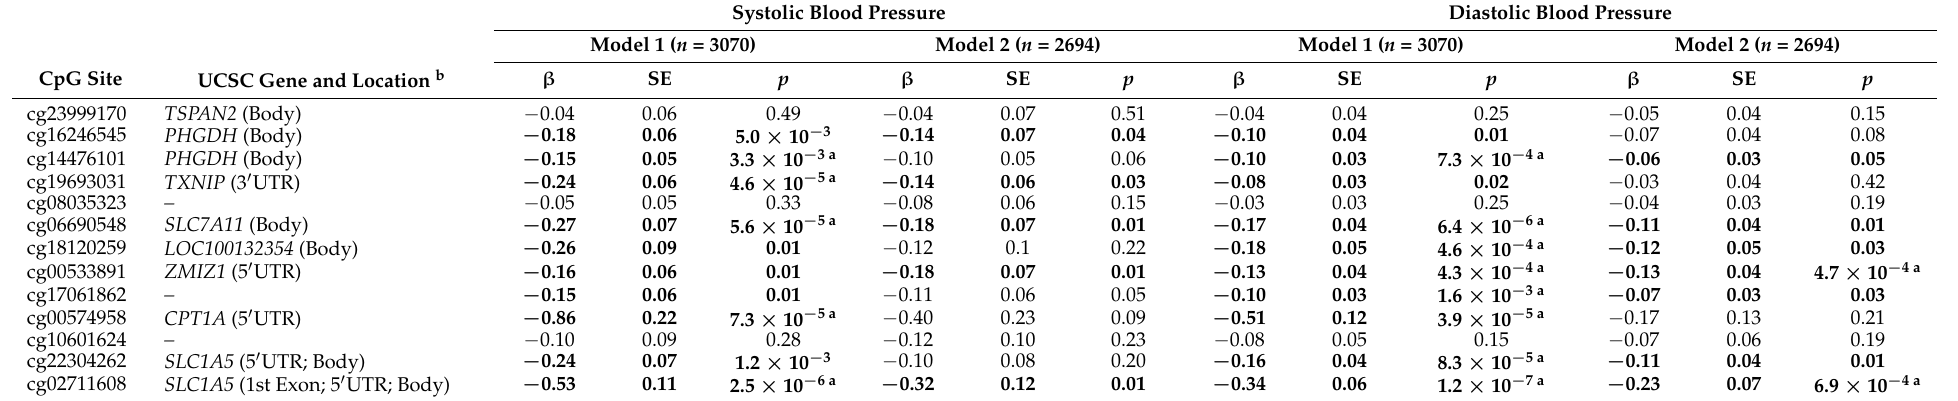
Table 2. Associations between 13 blood pressure-associated CpGs and systolic or diastolic blood pressure in full sample of the Health and Retirement